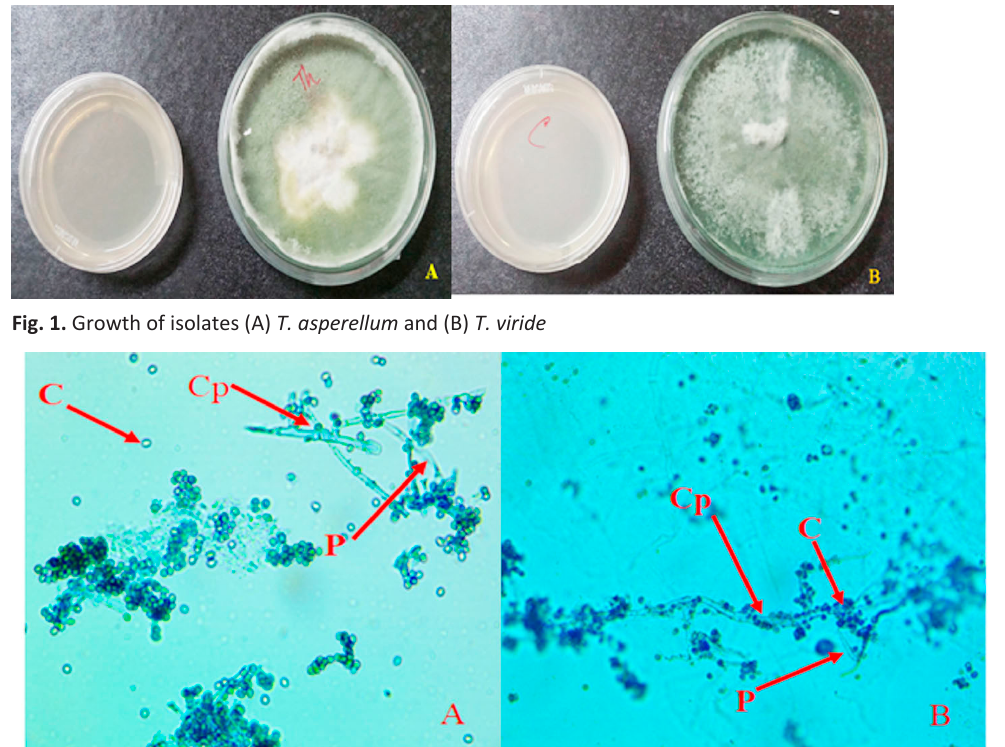
Fig. 2. Microscopic observation of isolates of (A) T. asperellum and (B) T.viride; Where Cp- Conidiophores, P-Phialides and C-Conidia